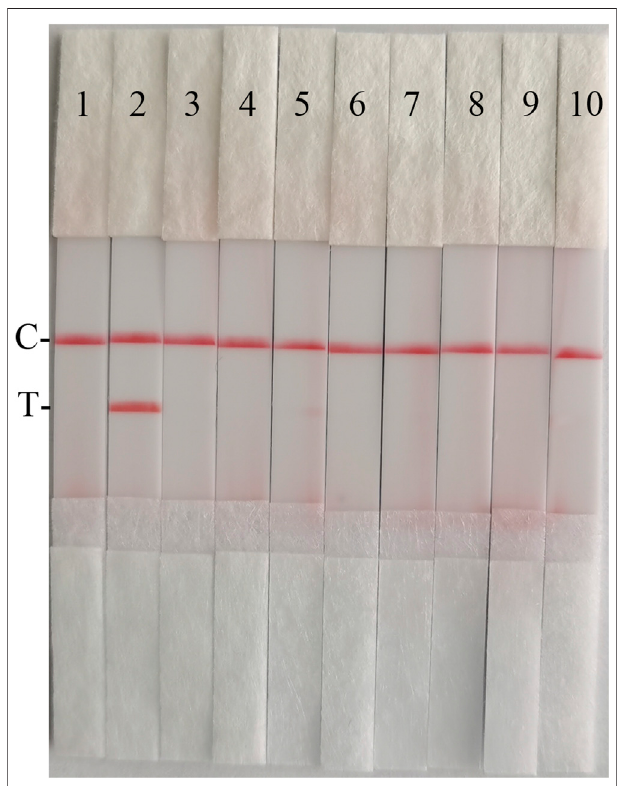
FIGURE 8 | The speci fi city of CSFV RAA-strip. C is a control line. T is a test line. Line 1 is a negative control. The speci fi city test result of CSFV RAA- strip using 9 different swine viruses, The templates used in lanes 2 – 7 successively are CSFV, ASFV, PPV, PCV2, FMDV, SVV, PRV, PRRSV, and